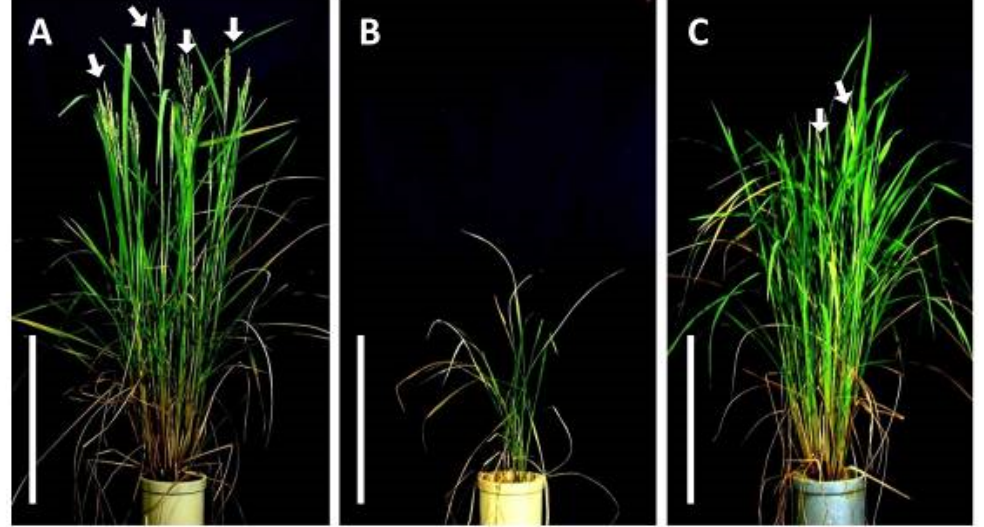
Figure 1. Parental and F 1 hybrid phenotypes at 80 days after sowing. ( A ) Oryza sativa ‘A.D.T.14 ′ ; ( B ) F 1 hybrid; and ( C ) O. sativa ‘P.T.B.7 ′ . Arrows indicate emerging panicles. Scale bars indicate 50 cm.